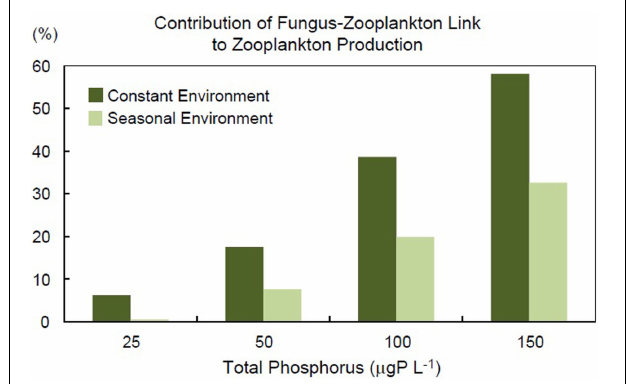
FIGURE 3 | Comparison of the contribution of the mycoloop pathway to zooplankton production under constant and seasonal environments. The relative percent contribution of the mycoloop pathway (large phytoplankton → parasitic fungi → zooplankton) to total zooplankton biomass production under constant and seasonal environmental conditions was calculated as the ratio of the F-Z link nutrient flux to zooplankton compared to the total nutrient flux to zooplankton (nutrient flux from the F-Z link plus nutrient flux from small phytoplankton) (see also Figure 2 ). The ratios of the contribution of the mycoloop under constant environmental conditions compared to that under seasonal environmental conditions was calculated for concentrations of total phosphorus (TP) = 25.0, 50.0, 100, 150 μ gP L − 1 to be 10.3, 2.30, 1.94, 1.78. TP in the model ecosystem was calculated by the average phosphorus supply I 0 divided by the turnover rate of the system (0.05/day). The daily fluctuation in the phosphorus supply I ( t ) (cid:6) (cid:7) 1 . 0 + 0 . 5sin(2 π t / 365) for the seasonal environment; is given by I ( t ) = I 0 the maximum deviation from average is ± 50%. Modified from Miki et al. (2011).